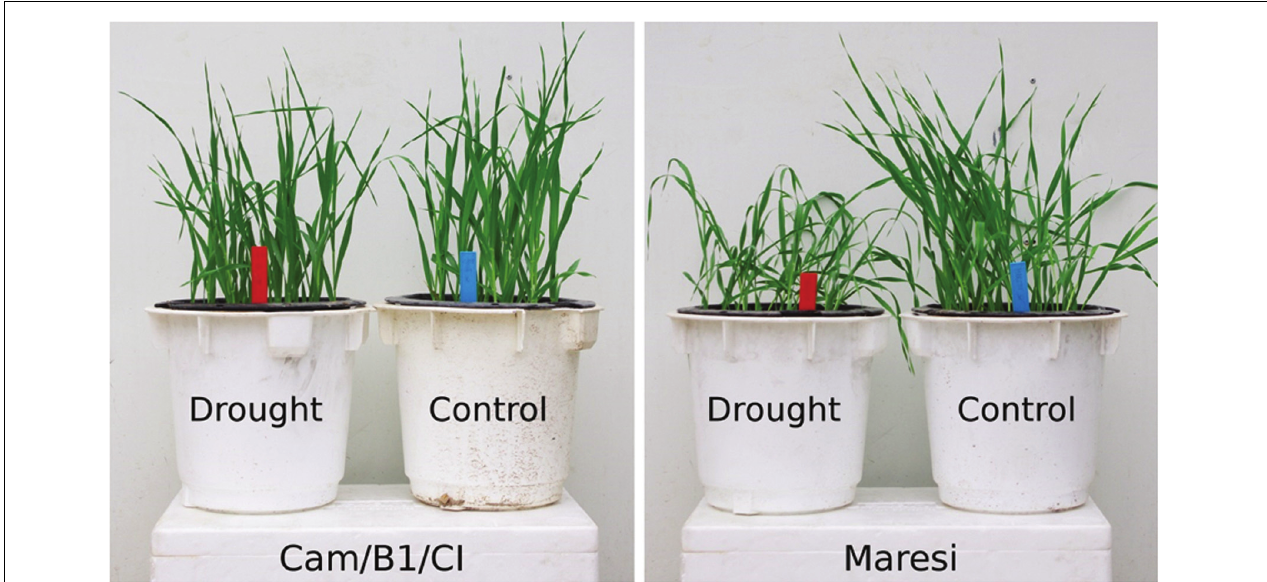
FIGURE 1 | Growth phenotypes of Maresi and Cam/B1/CI plants exposed to the 10-days long drought conditions.